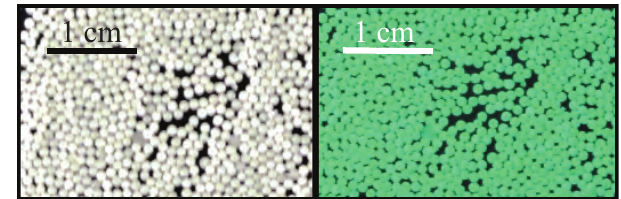
Fig. 1. Left, view of a 0 . 8 mm sample of off-the-shelf fluorescent particles under daylight, and right, under 365 nm UV light.